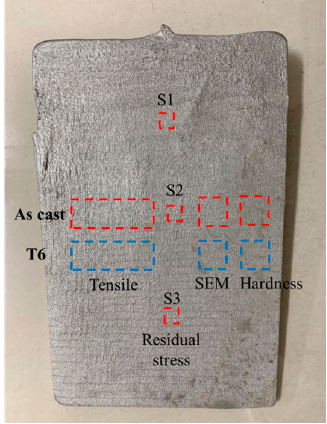
Figure 7. On-site pouring experiments: ( a ) natural cooling and ( b ) forced cooling. (C1 is the test point at the top of the molds, 30 mm from the top of the molds, C2 is the test point at the bottom of the molds, 30 mm from the bottom of the molds.)